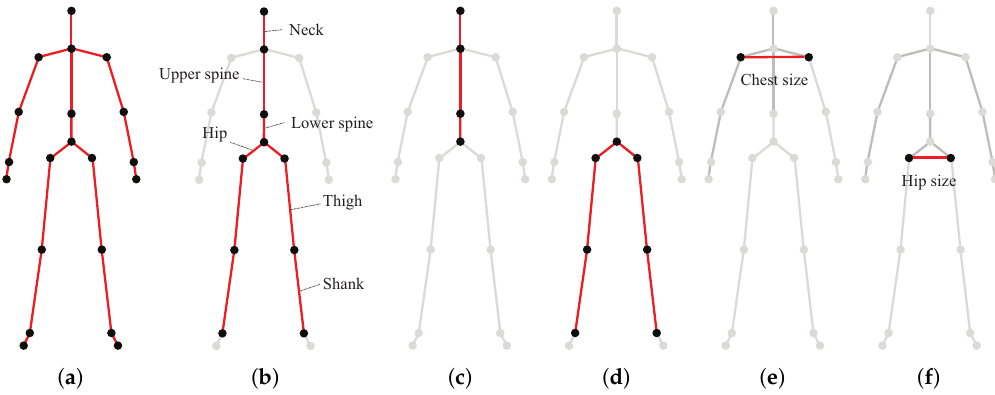
Figure 5. Anthropometric features by means of joints and limbs: ( a ) f 1 , ( b ) f 2 , ( c ) f 3 , ( d ) f 4 , ( e ) f 6 , and ( f ) f 7